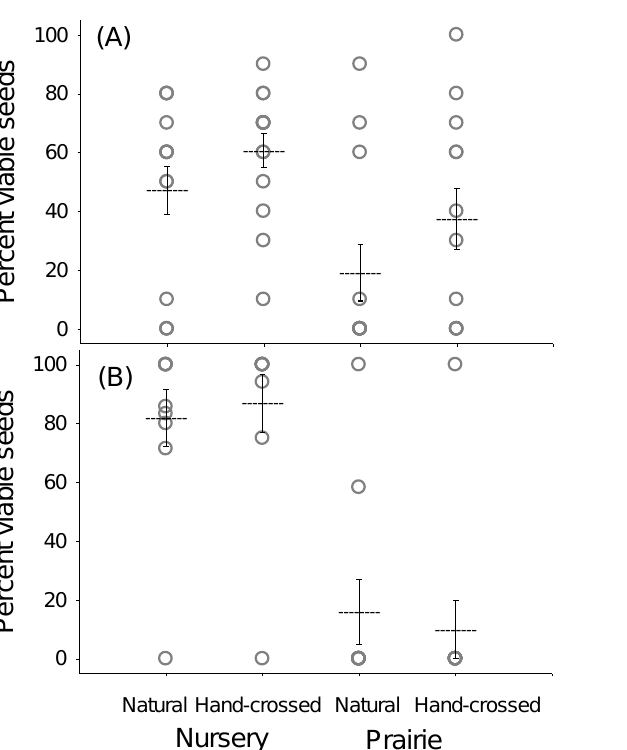
F IGURE 3. Percentage of viable seeds produced by hand-cross pollination and natural pollination at either Webster Nursery or Johnson Prairie: A) Balsamorhiza deltoidea inflorescences, and B) Lupinus albicaulis inflorescences. Open gray circles represent percent viability and black horizontal lines represent means +/- 1 standard error. Bonferroni correction for two tests would necessitate an alpha =